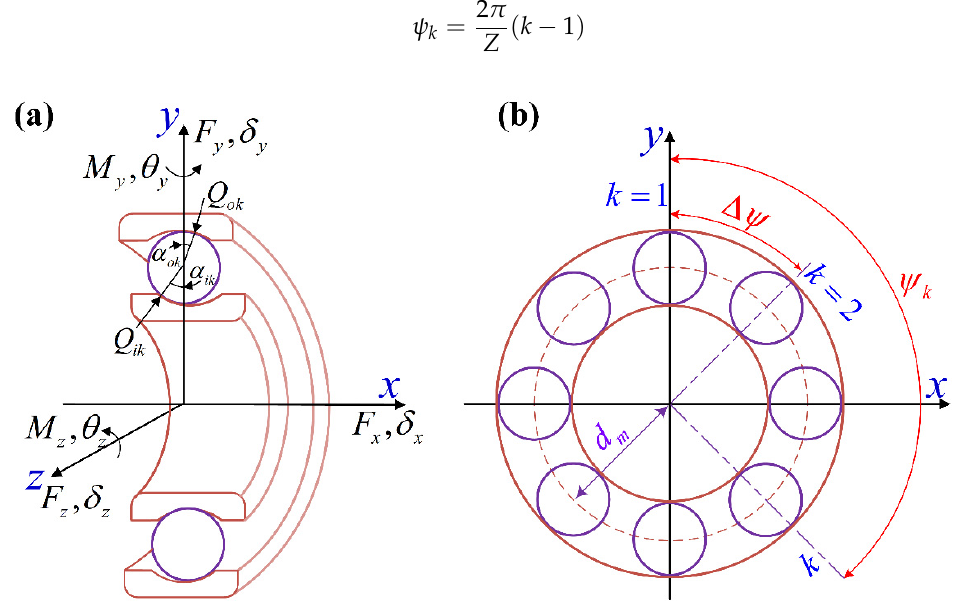
Figure 1. The coordinate systems for ball bearing: ( a ) Axial section and x axis coincided with the rotation center line; ( b ) Traverse section and ball position angle ( ψ k = 2 π ( k − 1 ) / Z ). It is assumed that the bearing is acted by a combined external load vector F = { F x , F y , F z , M y , M z }, and the relative displacement vector between the inner and outer rings